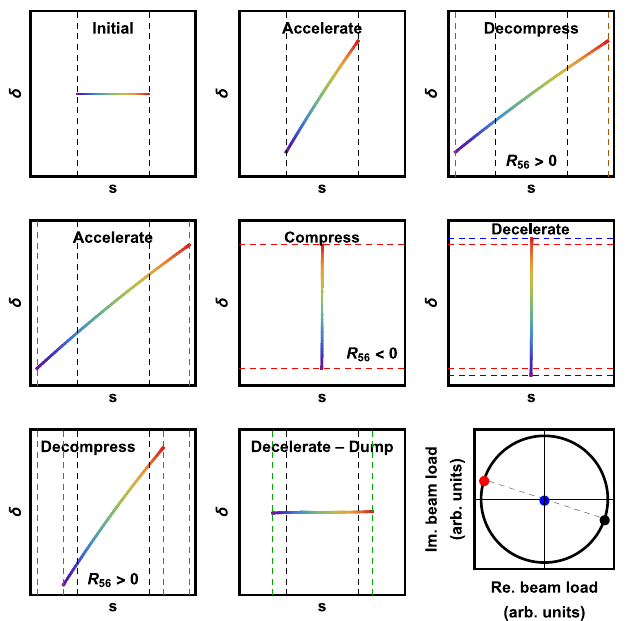
FIG. 14. Equivalent of example IA shown in Fig. 4 but bunch decompression does not occur at top energy. The bunch under- goes decompressions during acceleration and deceleration result- ing in a bunch longer at the dump than at the injector. Black dashed lines indicate initial bunch length, orange dashed line indicates maximum bunch length, green dashed line indicates final bunch length, red dashed line indicates bunch energy spread at top energy and blue dashed line indicates adiabatic growth of energy spread of the decelerating fully compressed bunch. rf beam load plot shows phase choices during acceleration (black), deceleration (red), and resultant (blue).